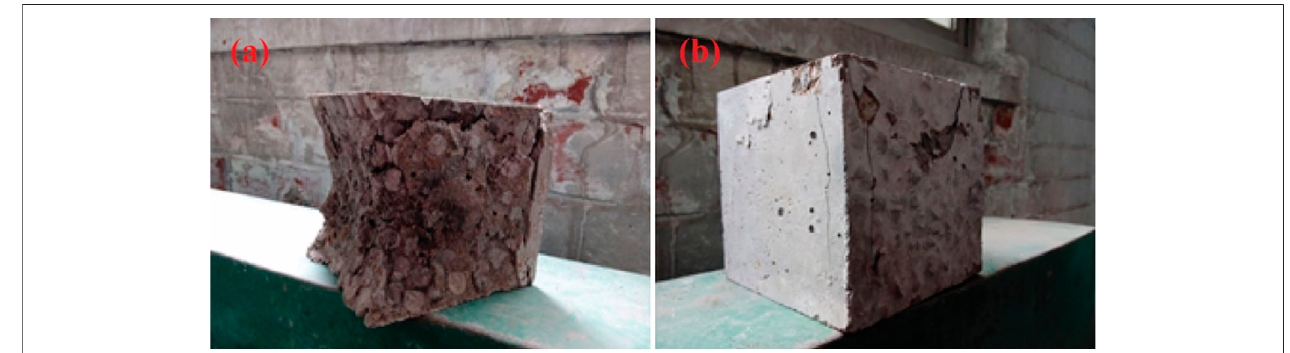
FIGURE 7 | Compressive failure of (A) concrete without steel fi ber and (B) concrete with steel fi ber content of 1.5%.